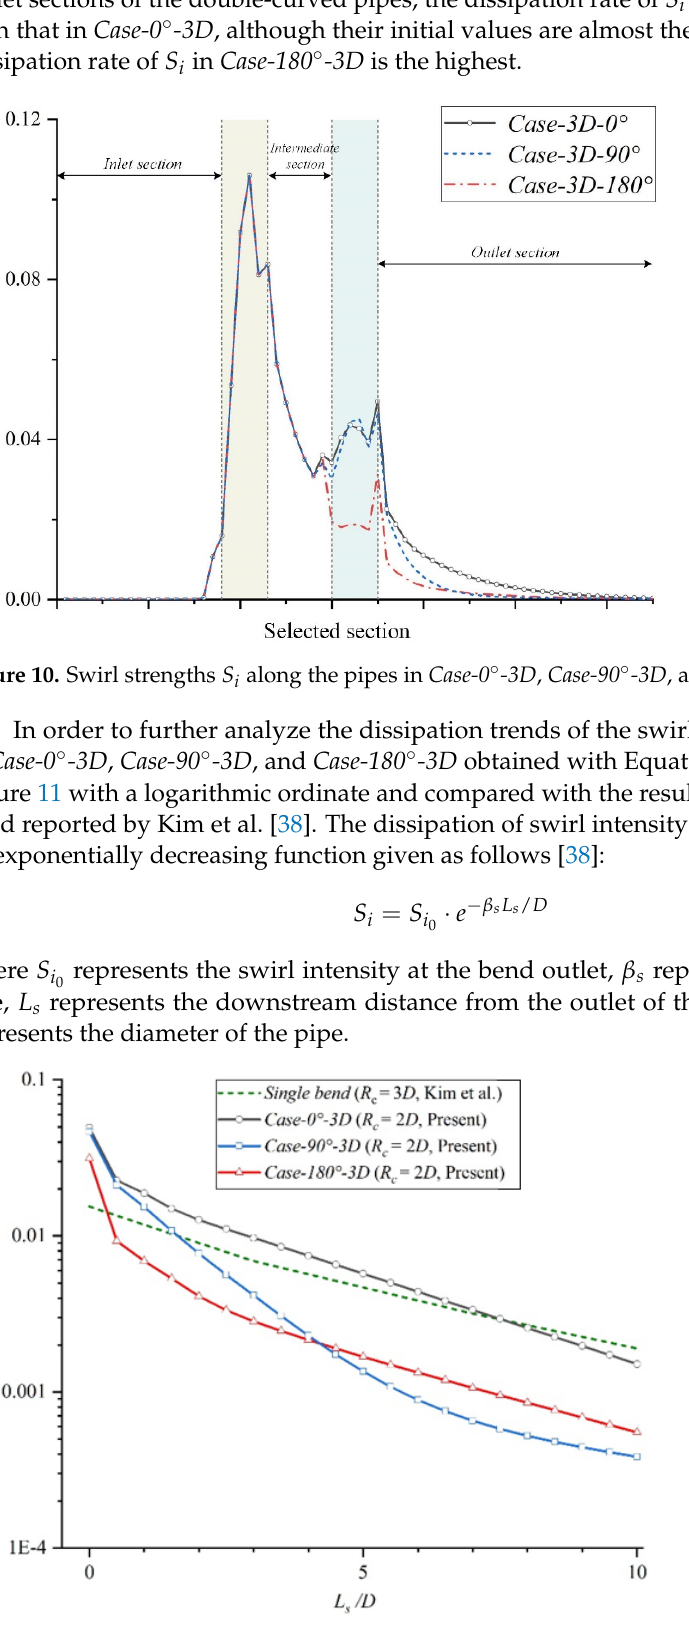
Figure 11. Dissipations of swirl intensity downstream a single bend and second bends in Case-0°-3D , Case-90°-3D , and